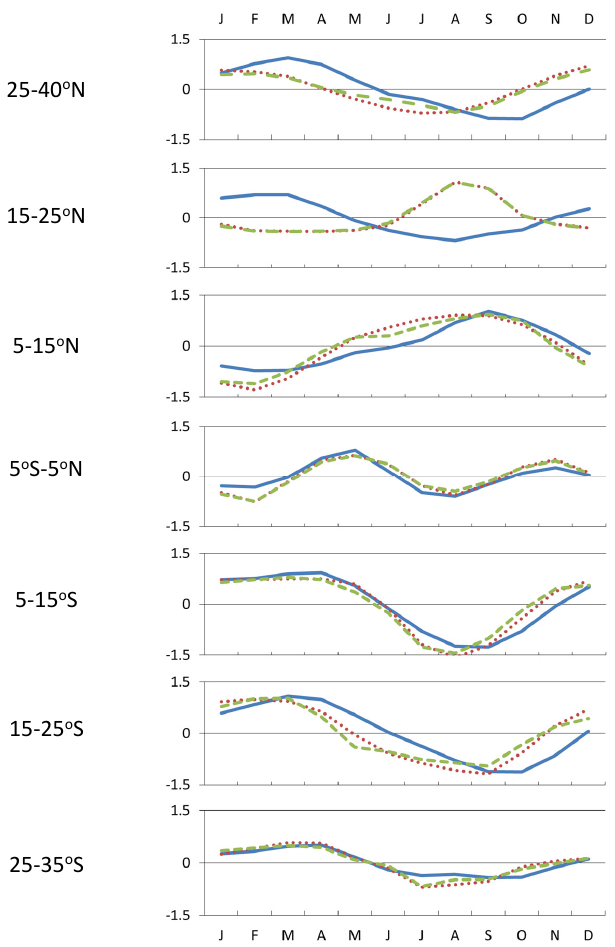
Fig. 4. Standardised anomalies of monthly observed NDVI and FPAR, modelled by LPJ-GUESS with and without land use (LU) functionality, relative to the grid cell mean and standard deviation, averaged over latitude bands for the period 1982–2006. Simulation S0, “LPJ-GUESS”, represents potential natural vegetation only, while simulation S1.7, “LPJ-GUESS LU”, represents potential natural vegetation plus cropland and pasture. Cropland is simulated without cover crop